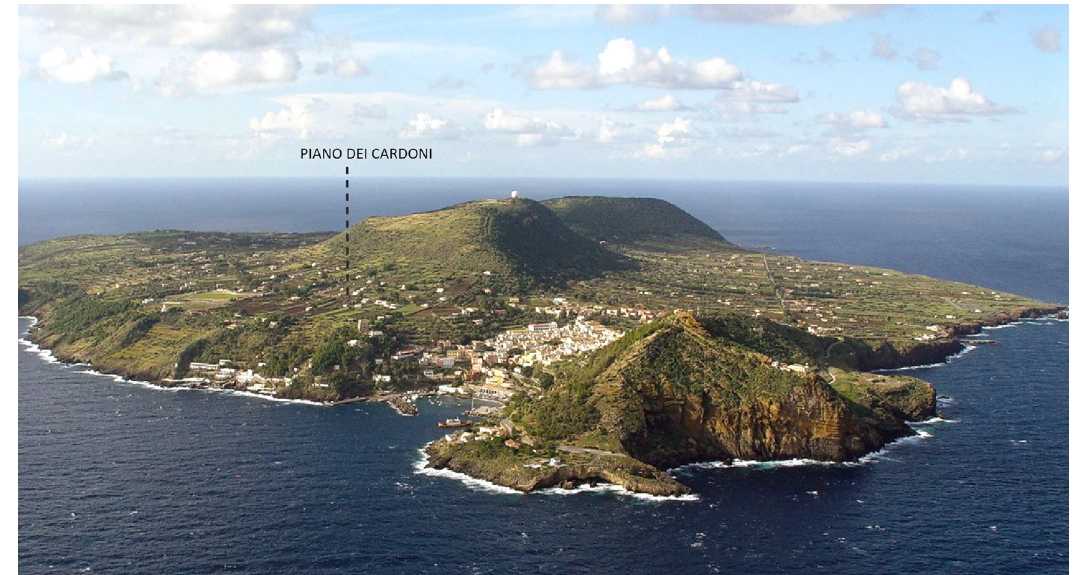
Figure 1: View of the island of Ustica from East and position of Piano dei Cardoni ( Source: it.geonews.com )